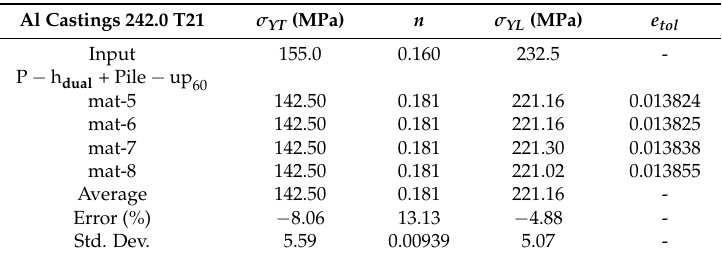
Table 5. Material parameters identified from inverse analysis using both the indentation P-h curves and pile-up